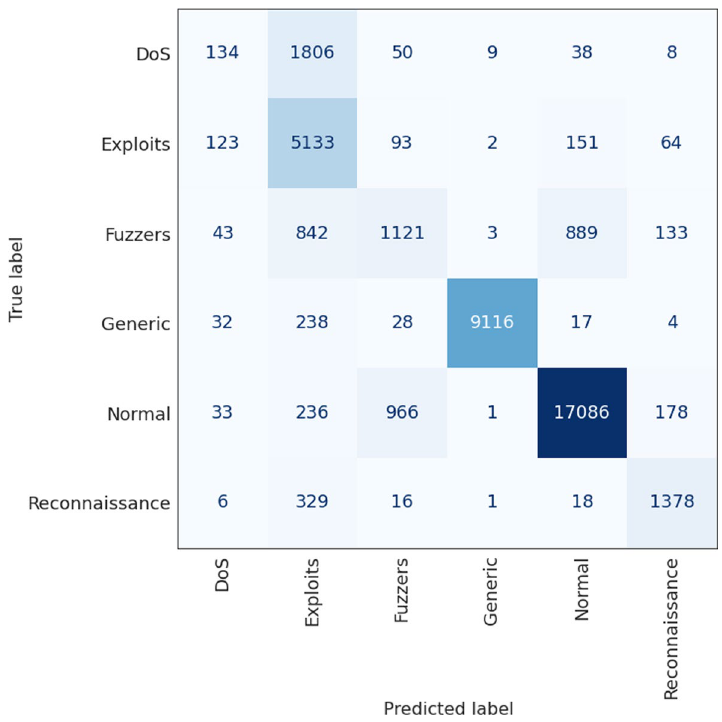
Table 7 Evaluation metrics of multi‑classification of UNSW‑NB15 Precision Recall F1 Score FPR Accuracy DoS 0.3612 0.0655 0.1109 0.0062 84.24% Expl. 0.5980 0.9222 0.7255 0.0993 Fuzz. 0.4930 0.3698 0.4226 0.0309 Gene. 0.9982 0.9662 0.0005 Norm. 0.9388 0.0510 Recon. 0.7807 0.0100 Weighted Avg.